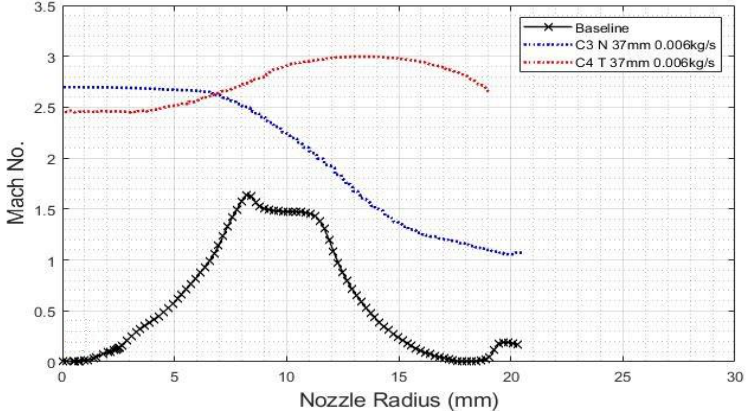
Figure 12. Mach number vs. nozzle radius of C3 and C4.